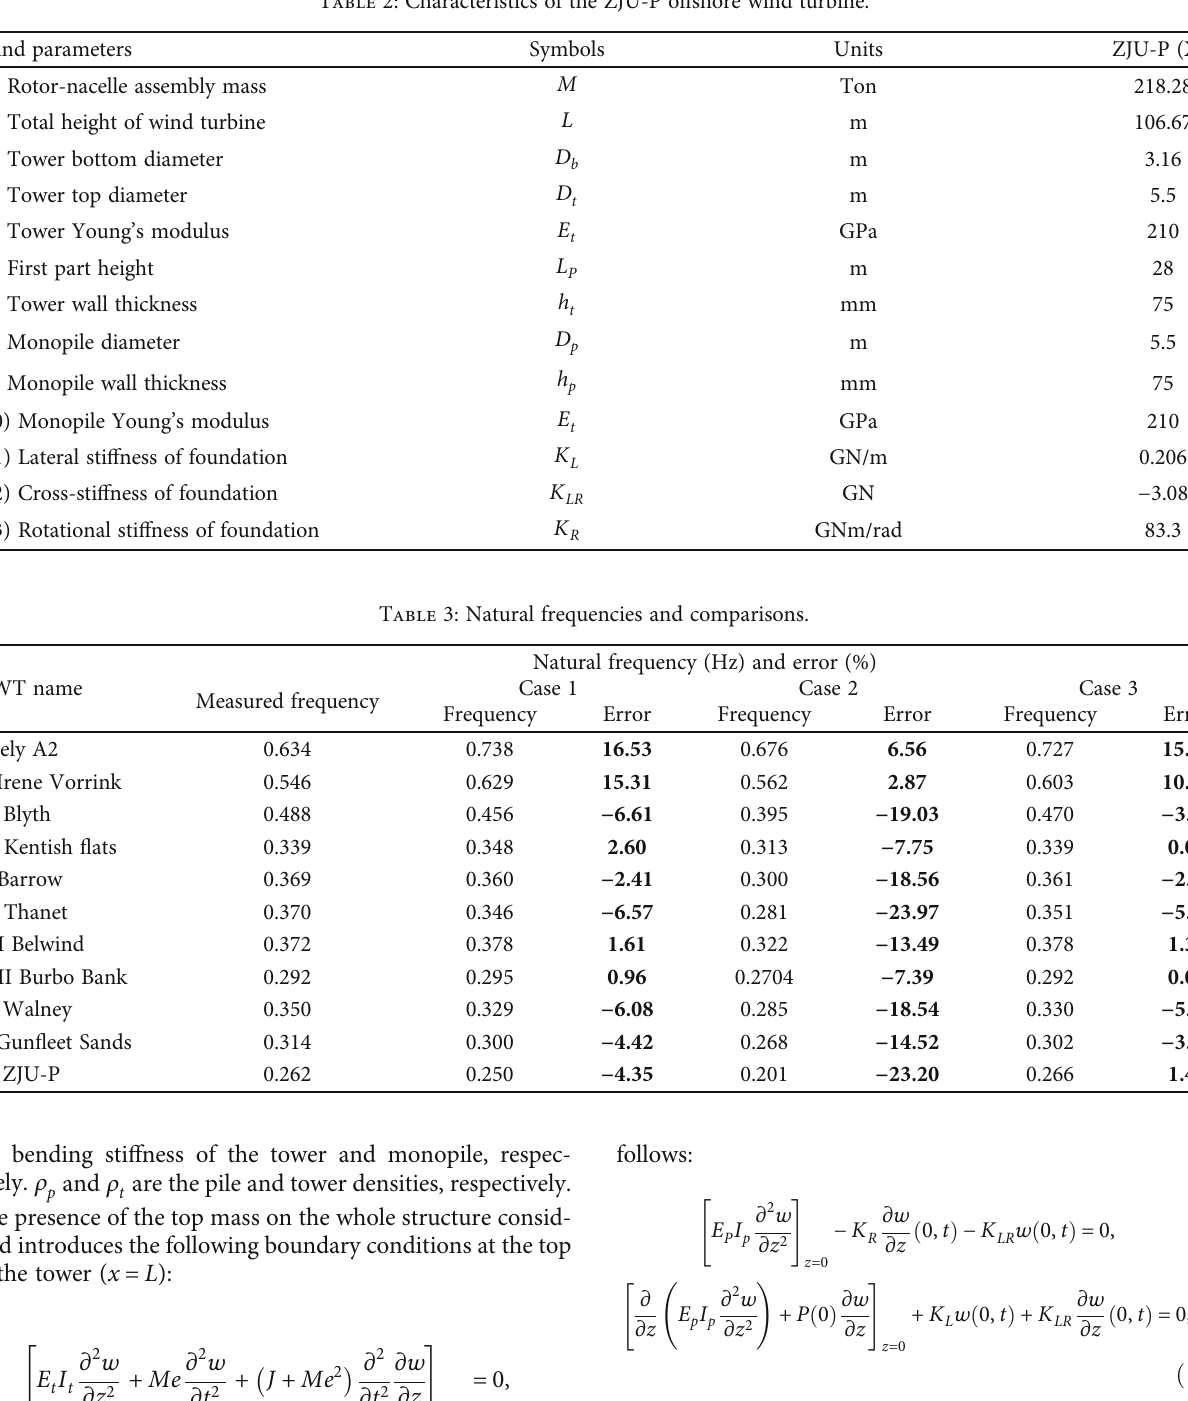
Table 2: Characteristics of the ZJU-P o ff shore wind turbine.